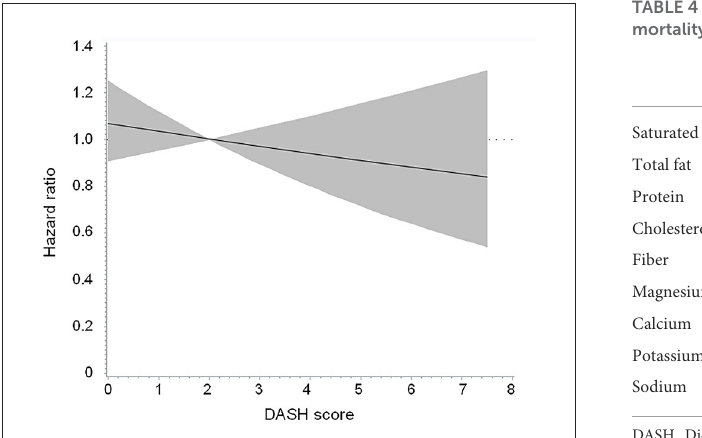
FIGURE2 Cubic spline of DASH score vs. risk of all-cause mortality in the overall population. The p -value was 0.423 for testing for linear relation. DASH, Dietary Approaches to Stop Hypertension.